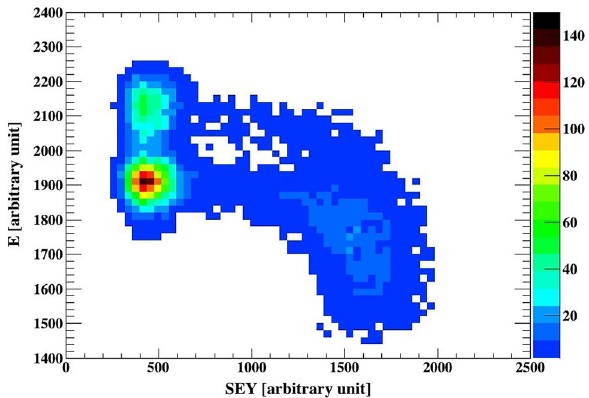
Figure 5. The energy measured with the Si detector versus SEY for the ZnO/GaN sample. The histogram binning for both observables is reduced by a factor of 2 compere to the rest of the histograms show in this work. The histogram demonstrates the correlation between the energy loss in the sample and the SEY. Higher SEY is related to Au ions with lower energy after the sample, i.e. ions which passed through a nanotube. The continuous change of SEY between channels 600 and 1200 as a function of energy after the target can be caused by ZnO material deposited in the lulls or broken tubes.